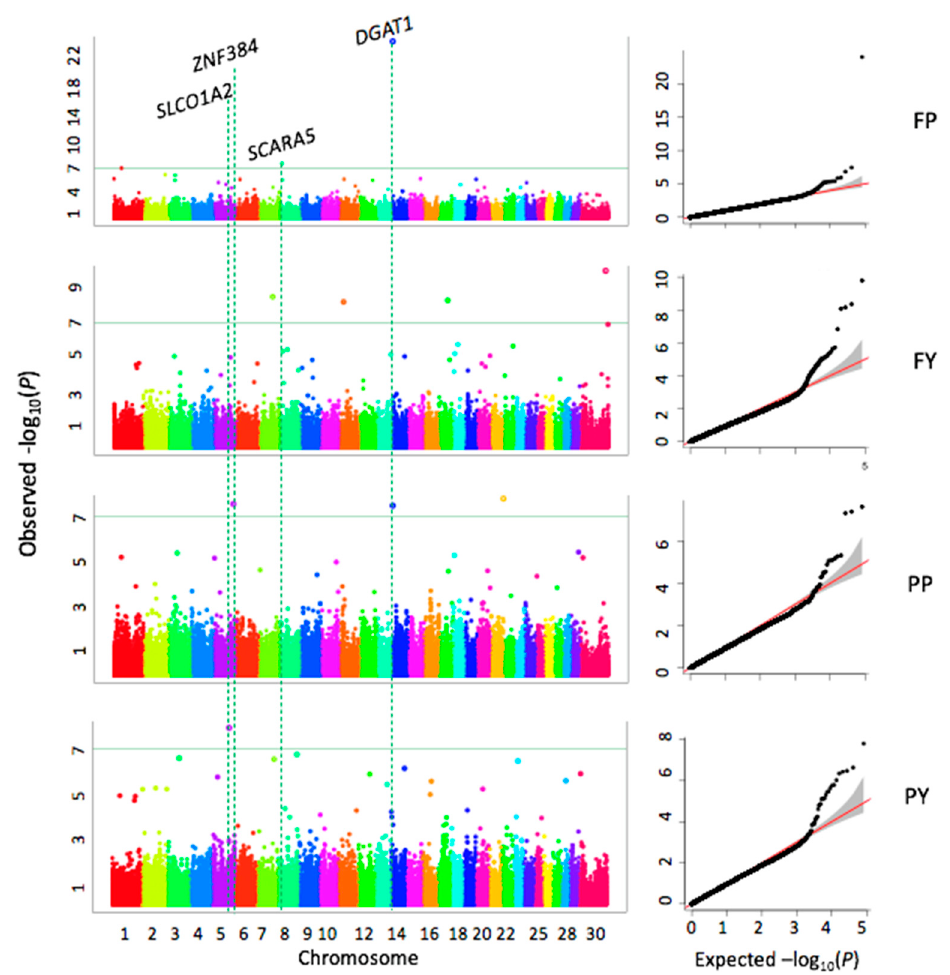
Figure 3. Associations between 124,743 SNPs and milk traits. Milk traits include fat yield (FY), protein yield (PY), fat percentage (FP), protein percentage (PP). The association analyses were conducted by the FarmCPU R package. Manhattan plots display the negative logarithms of the observed p values for SNPs across 30 bovine chromosomes (left panel). The green line indicates the Bonferroni multiple test threshold at p = 4.0 × 10 − 7 . The Quantile-Quantile (QQ) plots represent the negative logarithms of the expected p values ( X -axis) and observed p -values ( Y -axis) (right panel).